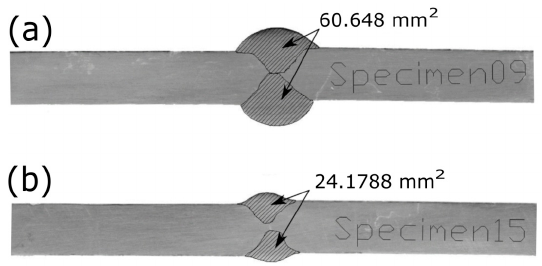
Figure 7. Weld cord areas at different GMAW input process parameters of current, voltage and speed.